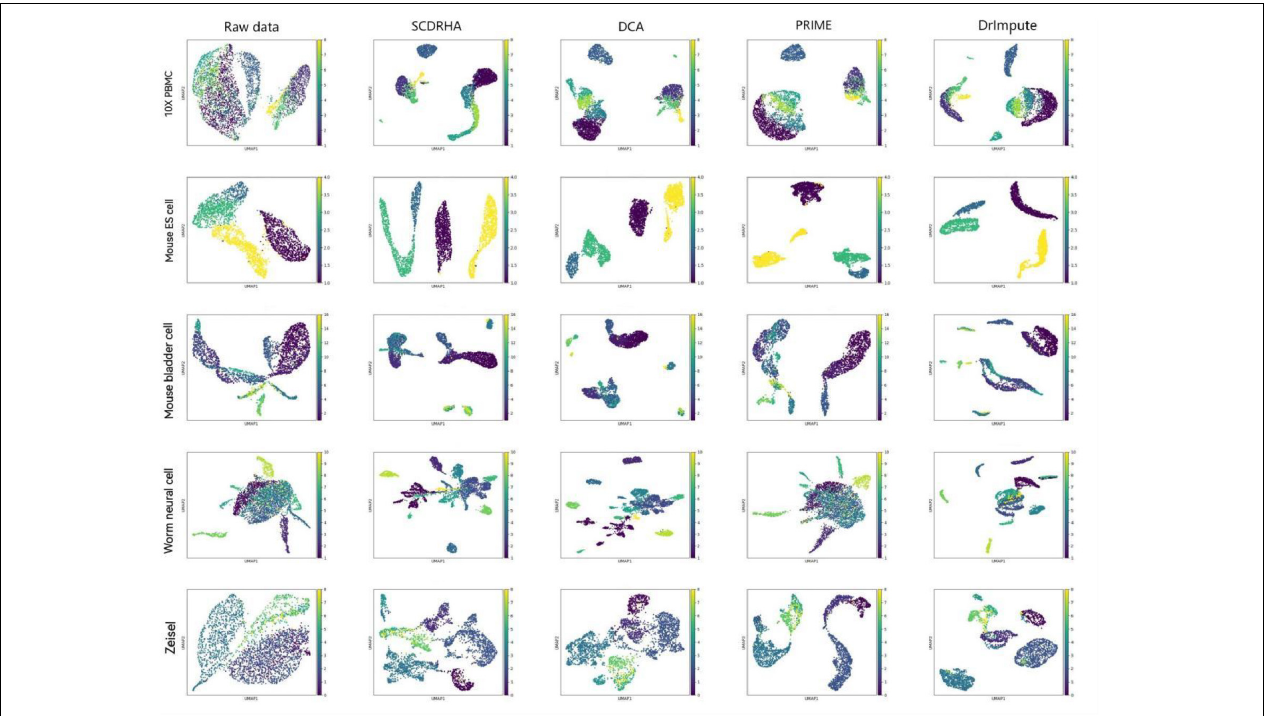
FIGURE 2 | Cell visualization results for all single-cell RNA sequencing (scRNA-seq) datasets. The columns, from left to right, represent the raw data and the data visualization after noise reduction by SCDRHA, DCA, PRIME, and DrImpute. The rows, from left to right, represent visualizations of 10X PBMC, Mouse ES cell, Mouse bladder cell, Worm neuron cell, and Zeisel datasets.